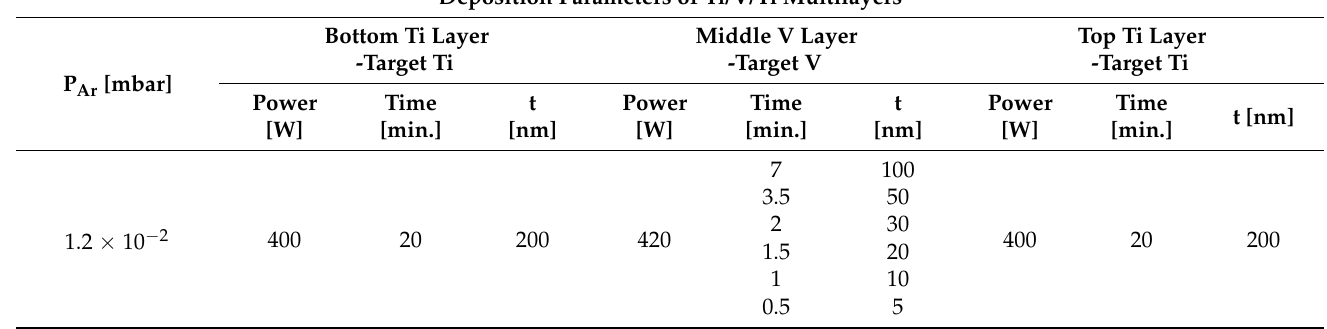
Table 1. Deposition parameters of Ti/V/Ti multilayers by pulsed DC magnetron sputtering with their